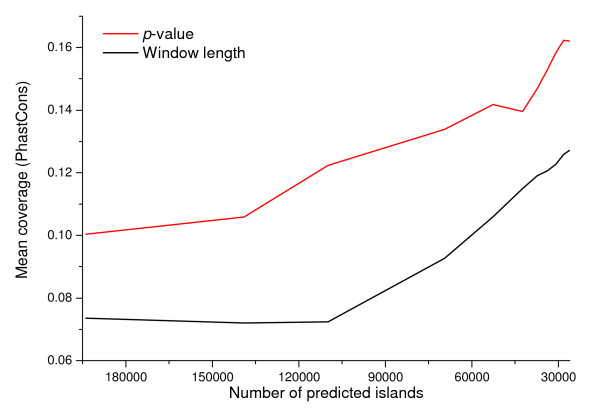
Variation of the mean coverage by PhastCons in different predicted island-sets obtained by varying the CpGcluster p-value and the SWA window length.